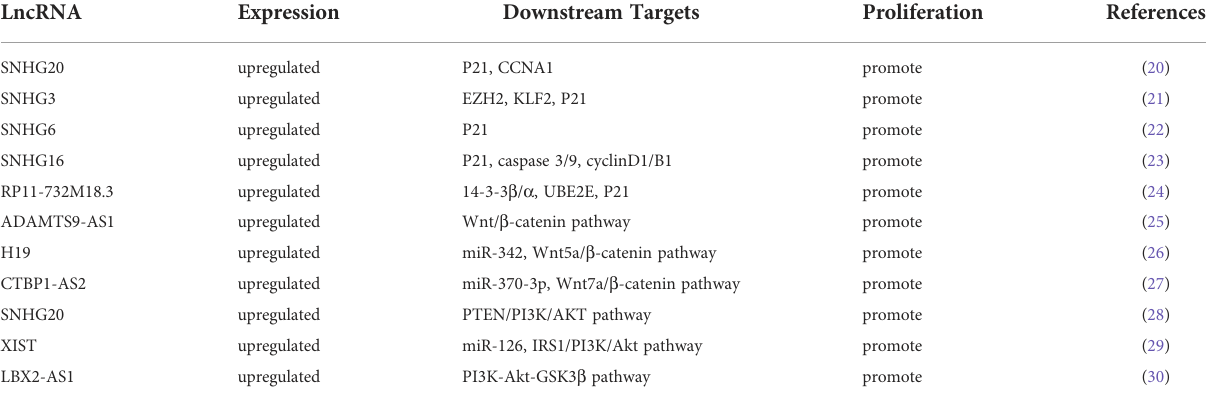
TABLE 1 Representative lncRNAs and related signaling pathways in glioma